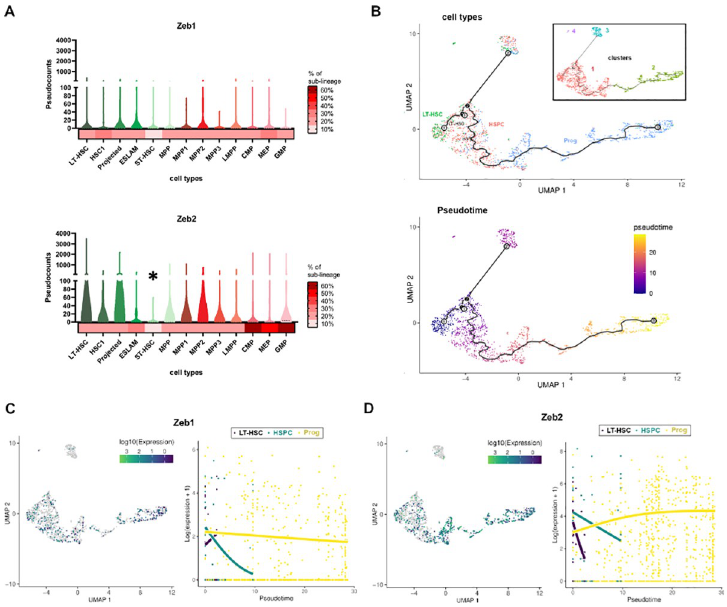
Fig 1. Expression analysis of Zeb1 and Zeb2 during early hematopoiesis. (A) Levels of Zeb1 (upper) and Zeb2 (lower) across LT-HSC (dark green to light green channels, Lin − c-Kit + Sca1 + CD34 – Flk2 – ), HSPC (dark red to purple, LSK) and progenitors (dark red to light red channels, LSK), respectively. Zeb2 levels are higher throughout except for ST-HSCs where Zeb1 levels are higher (asterisk). Heatmaps at the bottom of graphs show percentage of cell lineage that express Zeb1 or Zeb2 . HSPC subpopulations were subdivided into HSC1 and HSC2 (projected) expressing low/ absent and high SLAM marker CD229, respectively, including ESLAM cells (CD45 + EPCR + CD48 − CD150 + ). (B) (Upper) dimensionality reduction and trajectories of 3 major cell types (LT-HSC, HSPC, and Prog) across 1,920 hematopoietic single cells sequenced by Nestorowa and colleagues [19], analyzed with the Monocle3 algorithm [20]. Clusters identified by Monocle3 were enclosed in a black box. Two major clusters consisting in LT-HSC and HSPC (see clusters 1 and 3, respectively) and 1 cluster of progenitors (see cluster 2) were detected. Also, another restricted cluster of LT-HSC were found (see cluster 4). (Lower) Pseudotime fitting analysis of these cells with tradeSeq program [21]. (C) (Left) Expression of Zeb1 gene across the single cell experiment, color coded according to the log10 of Zeb1 pseudocounts. Cells with zero pseudocounts for Zeb1 expression are colored in gray. (Right) Estimated expression obtained for Zeb1 across cell types expressing Zeb1 and arranged by pseudotime with the tradeSeq program. Across pseudotime, fitted curves indicates up-regulation of Zeb1 expression in LT-HSC (black curve), down-regulation of Zeb1 in HSPC (green curve) and mild down-regulation of Zeb1 in progenitors (yellow curve). (D) (Left) Same as left C for Zeb2 gene. (Right) Same as right C for Zeb2 gene. Across pseudotime, fitted curves indicate up-regulation of Zeb2 expression in LT-HSC and HSPC (black and green lines, respectively) and up-regulation of Zeb2 in progenitors (yellow curve). HSPC, hematopoietic stem and progenitor cell; LSK, Lin − Sca1 + cKit + ; LT-HSC, long-term HSC; ST-HSC, short-term